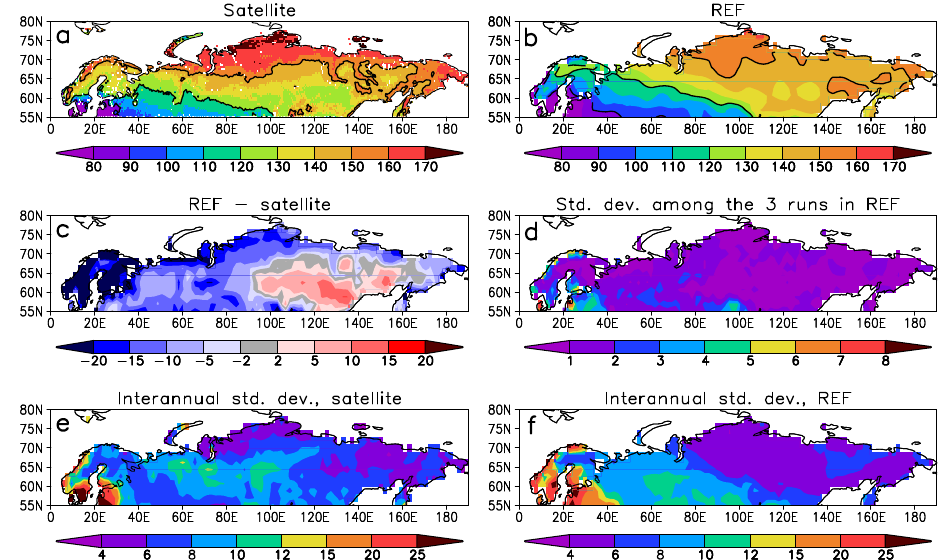
Figure 3. Mean snow-off date in years 1979–2006 based on (a) the satellite retrievals and (b) the REF experiment. Unit: day of year (Julian day). Snow-off dates of 90, 120 and 150 corresponding approximately to the beginning of April, May and June are indicated with black lines. (c) The difference in the average snow-off date between the REF experiment and the satellite retrievals. For computing the difference, the satellite snow-off dates were averaged to the model grid. (d) The standard deviation ( σ n − 1 ) in 28-year mean snow-off date among the n = 3 differently initialized runs included in the REF experiment. (e) The standard deviation of yearly snow-off dates in the satellite retrievals (for snow-off dates averaged to the model grid), and (f) in the REF experiment (computed first separately for the three runs in REF and then